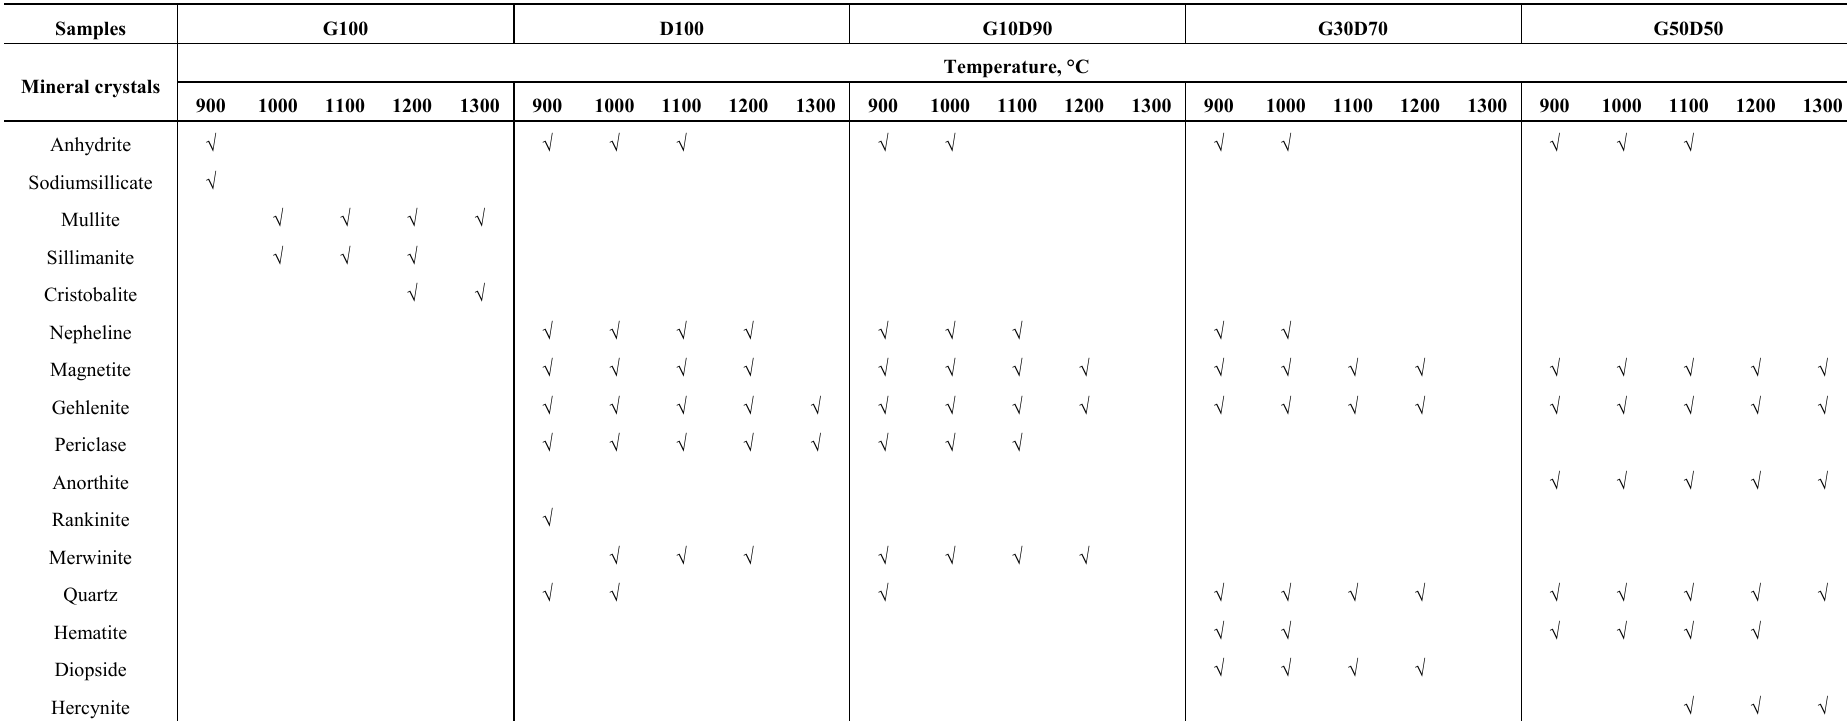
Table 3. Mineral crystals formed in ash samples at different